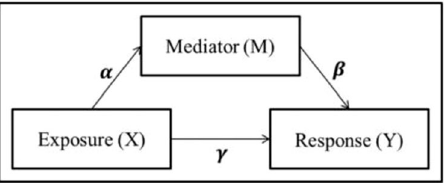
Figure 4. Representation of a mediation model with an exposure (X), mediator (M) and response (Y) and their relationships (α, β,